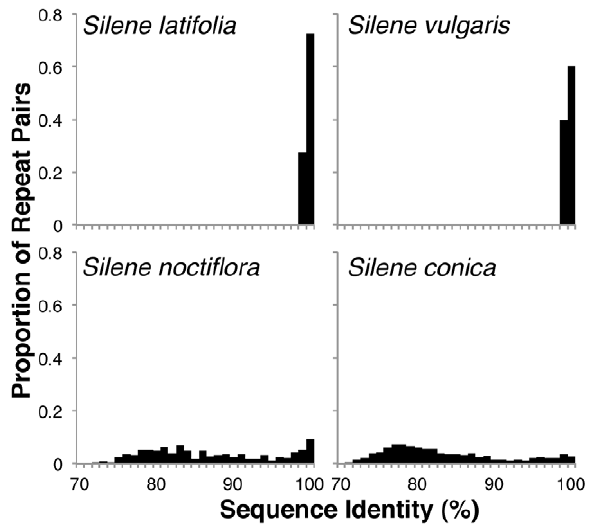
Figure 7. Distribution of percent sequence identity between pairs of repeats detected by BLAST. Only repeat pairs greater than 300 bp in length were used to calculate these distributions.